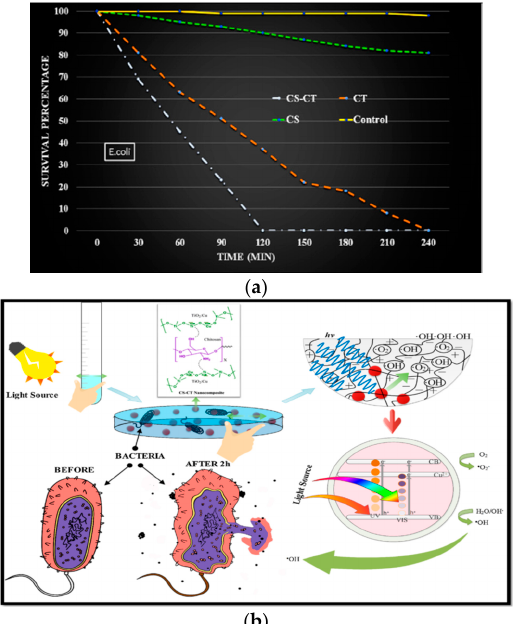
Figure 31. ( a ) Antibacterial activity of CS, CT and CS–CT samples against E. coli under visible light illumination. ( b ) Mechanism of antibacterial activity of CS/Cu-doped TiO 2 nanocomposite. Reproduced with permission from [288]. Copyright Elsevier, 2011.